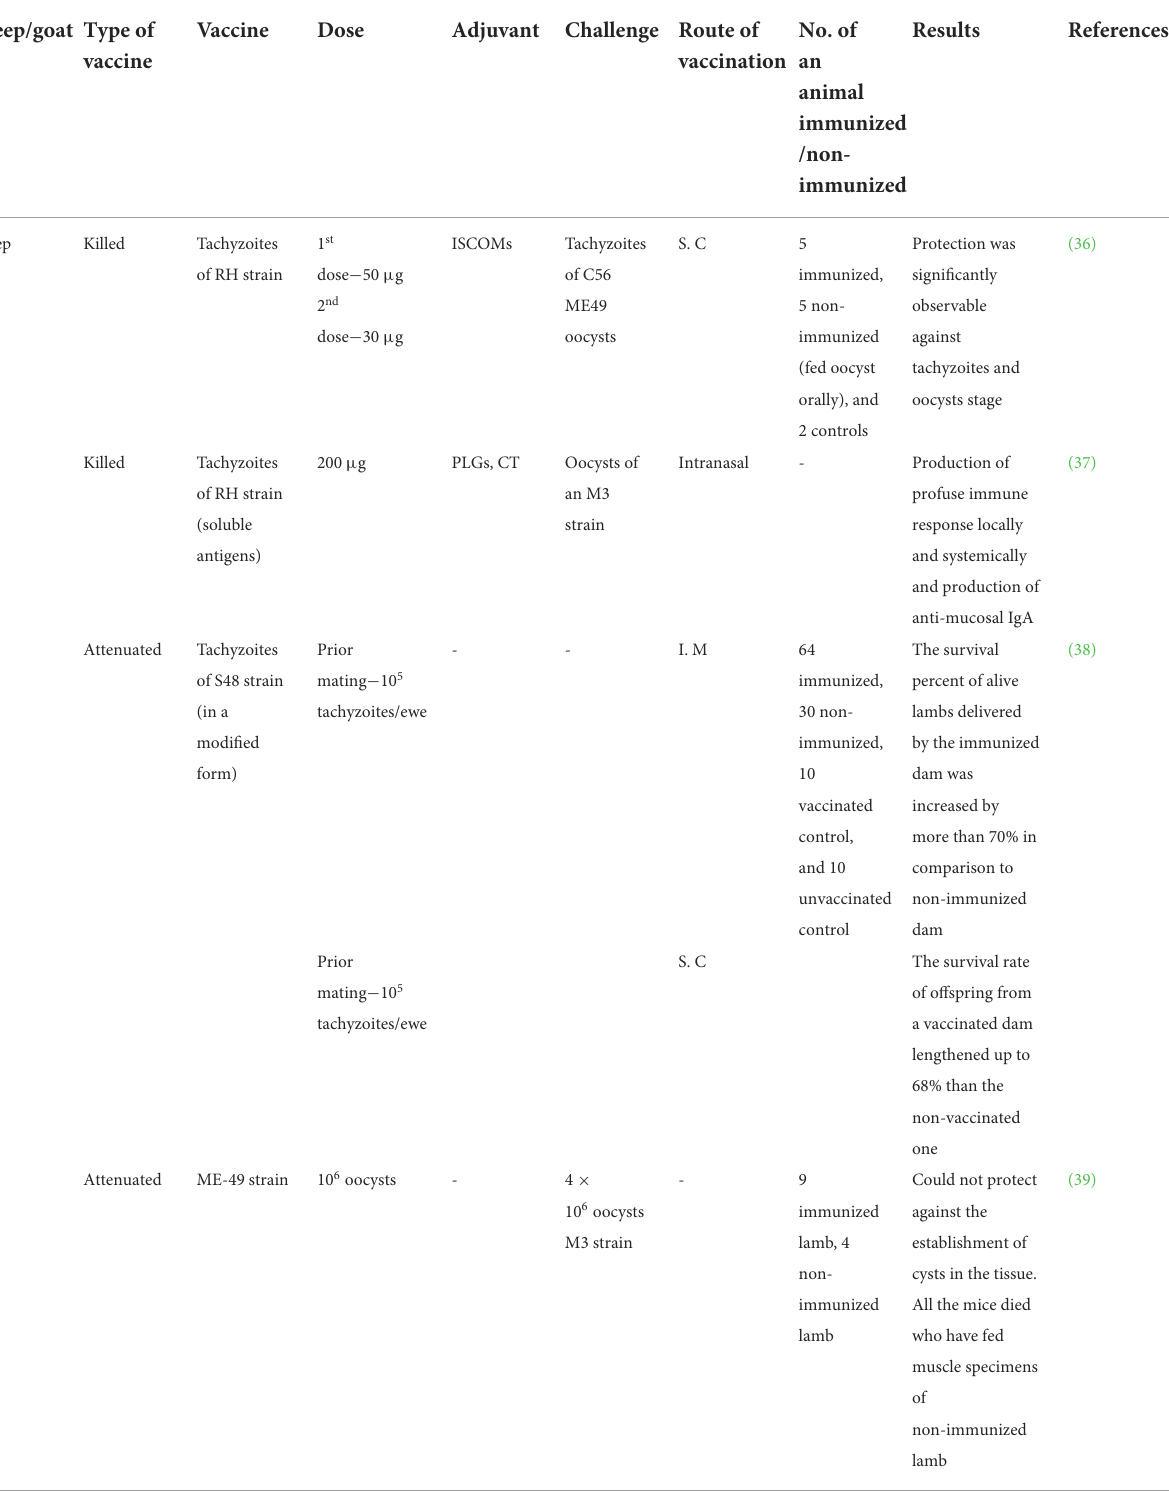
TABLE 1 Characteristics of the developed vaccines against toxoplasmosis in sheep and goats. Sheep/goat Type of Vaccine Dose Adjuvant Challenge Route of vaccine